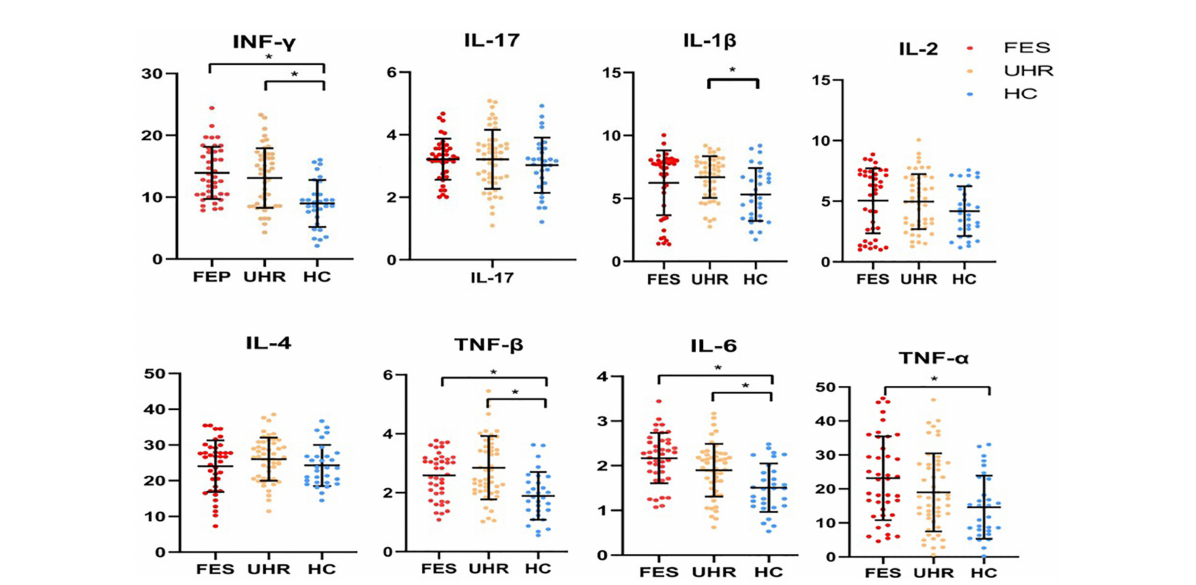
FIGURE1 Comparison of cytokines level among the three groups [FES, UHR, HCs, Cytokine concentration (pg/ml)]. Picture shows several significantly different inflammatory analytes between three groups, including IFN- γ , IL-1 β , TNF- β , IL-6, and TNF- α , In Post hoc comparisons, the Bonferroni procedure revealed that FES patients and UHR subjects exhibited significantly higher mean concentrations of IFN- γ , TNF- β , and IL-6 than HC subjects. Besides, IL-1 β concentration was significantly higher in UHR group than HC group, and TNF- α concentration remarkably increased in FES group relative to HC group. *The difference is significant with a p -value of less than 0.05. HC, healthy controls; UHR, ultra-high risk of psychosis; FES, Drug-naïve first-episode schizophrenia.